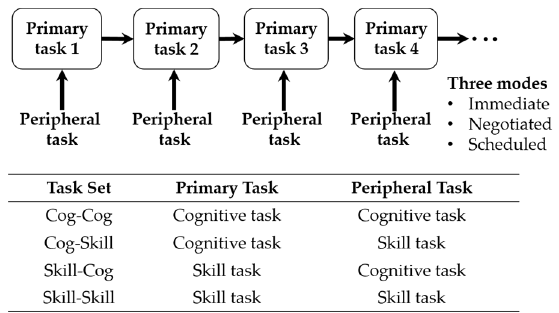
Figure 3. Experiment design.